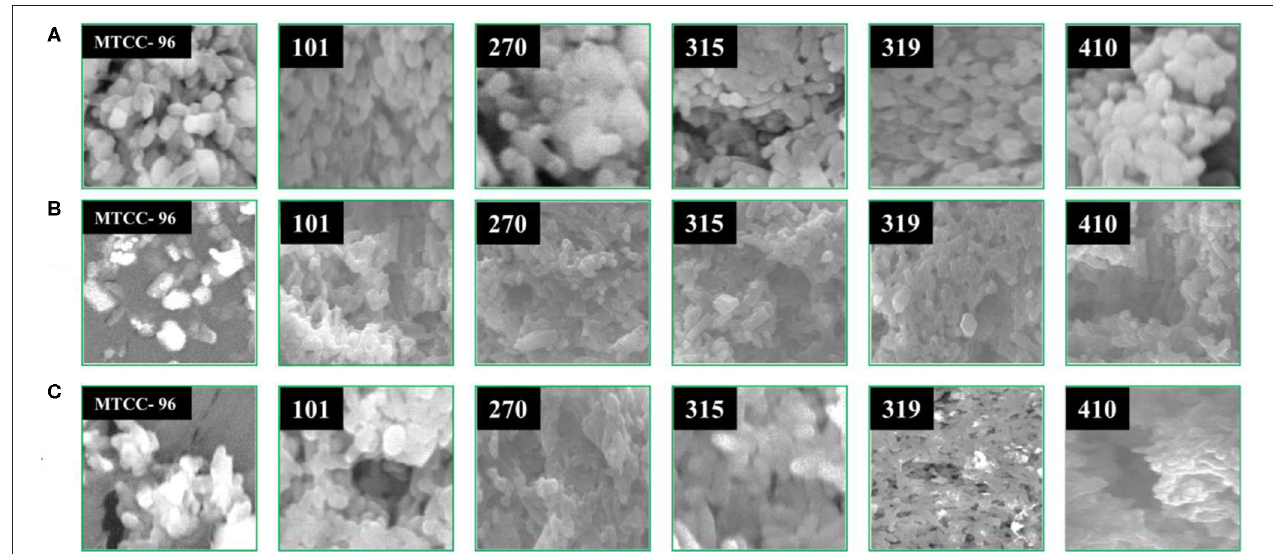
FIGURE 4 | The effect of arborine and skimmianine on the morphology of different MDR Staphylococcus aureus strains observed under scanning electron microscopy. (A) Control (without any treatment), (B) arborine-treated, and (C) skimmianine - treated S. aureus cells (the numbers on the images represent the S. aureus strain